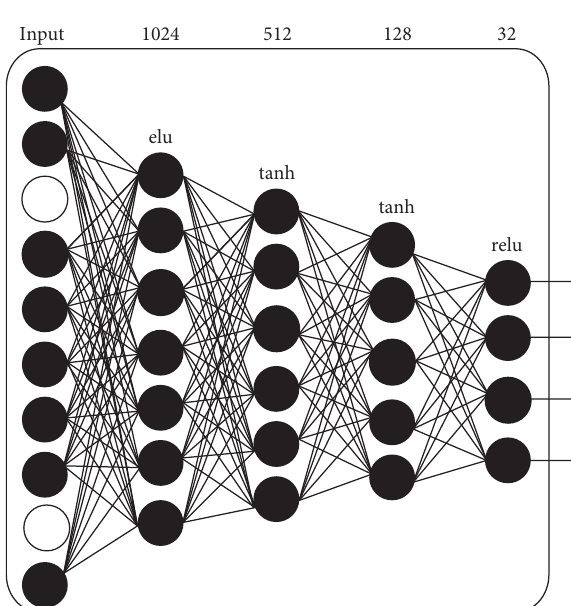
Figure 2: Detailed MLP block in DANN structure.